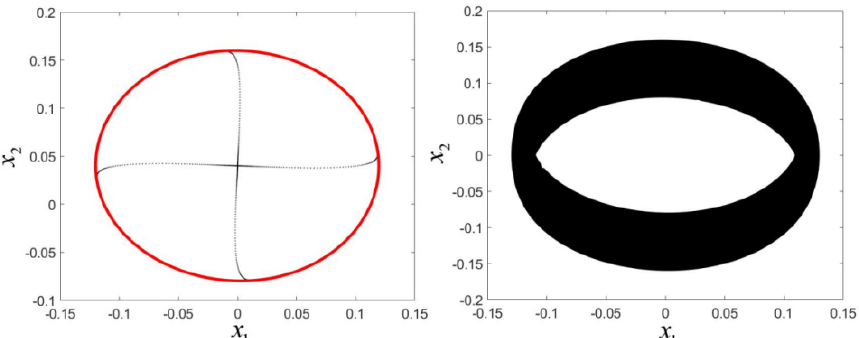
Figure 5. The stable quasi-periodic motion in 1:4 resonance when µ = 0.02: ( left ) the stable invariant circle; ( right ) the stable quasi-periodic motion.